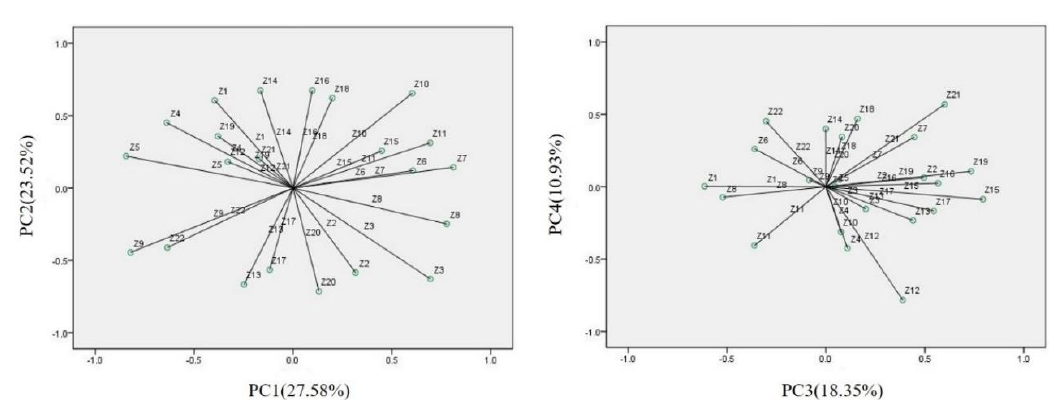
Figure 3. The scatter plots of the constituents. PC1, principal component 1; PC2, principal component 2; PC3, principal component 3; and PC4, principal component 4. Z1 to Z22 represent the oil content, acid value, peroxide value, iodine value, lauric acid, myristoleic acid, palmitic acid, stearic acid, oleic acid, linoleic acid, eicosenoic acid, α -tocopherol, polyphenols, squalene, Mg, Ca, Mn, Fe, Zn, Cu, Cr and Pb, respectively.